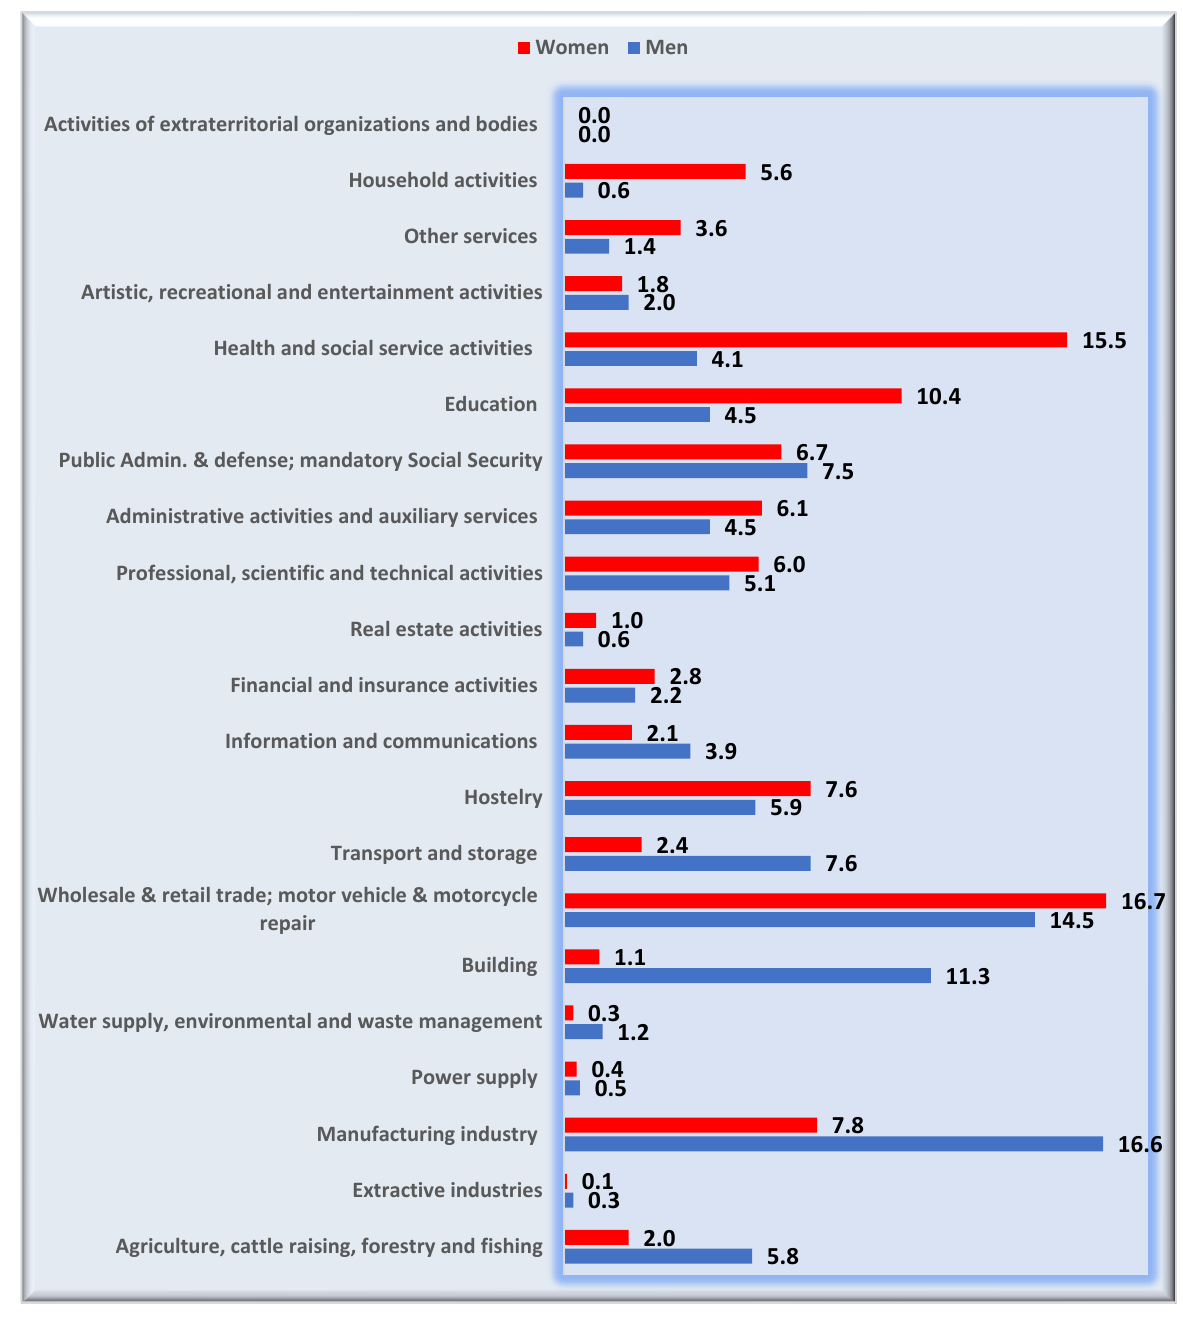
Figure 6. Working persons in Spain by sex and activity branch (percentages). Source: Authors with data corresponding to the fourth quarter of 2020 provided by the Statistics National Institute ( Instituto Nacional de Estadística ).